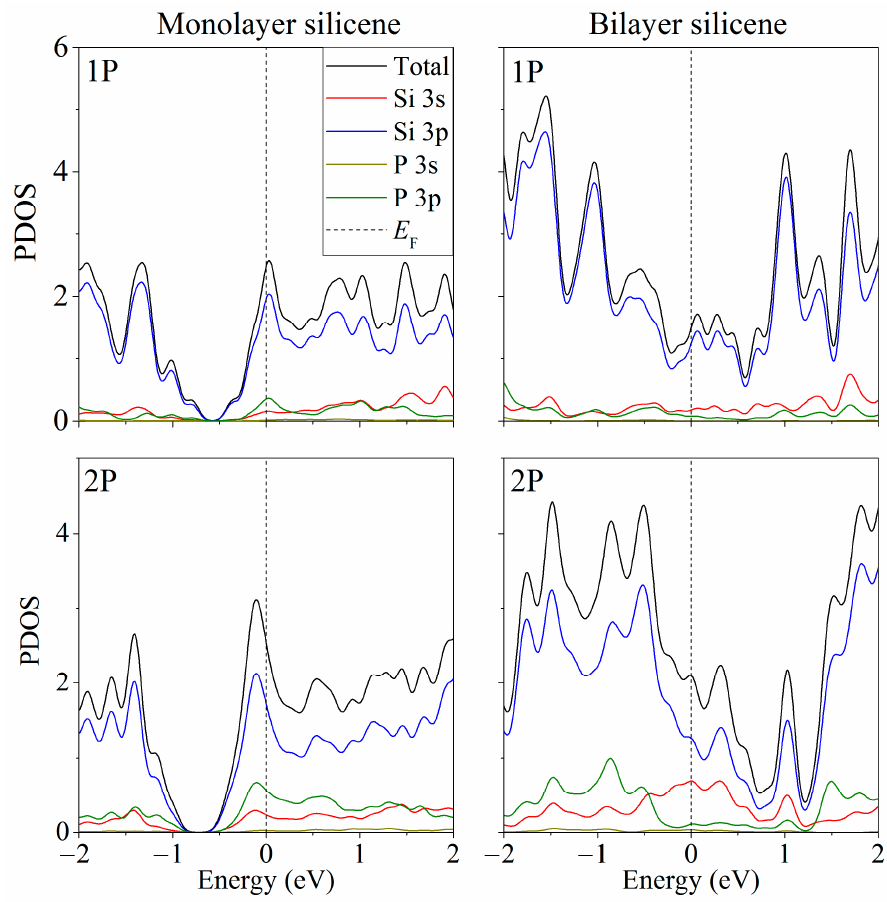
Figure 3. Partial spectra of electronic states of one- and two-layer silicene obtained from the replace- ment of 1 to 2 silicon atoms by phosphorus.